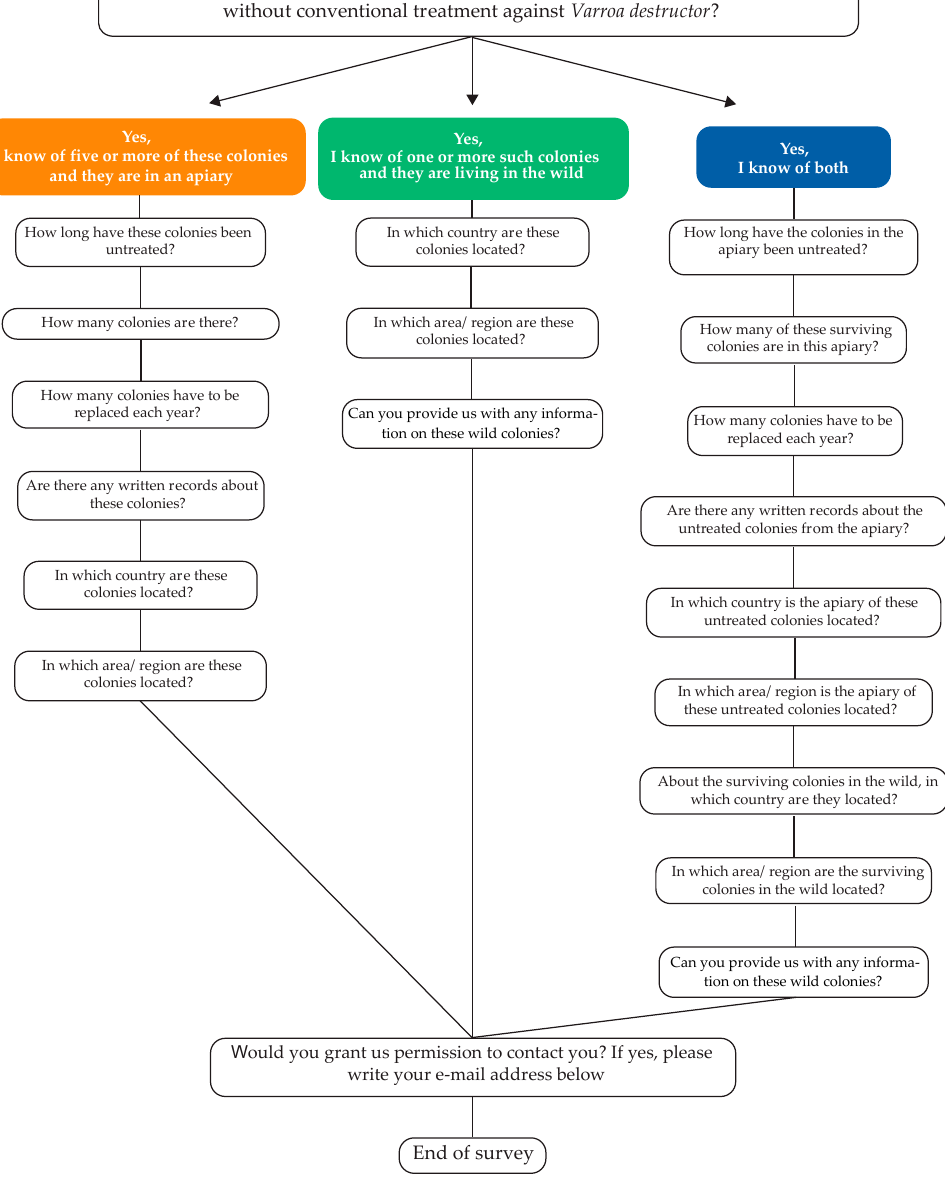
Figure 1. Flow diagram of the online survey on honey bee, Apis mellifera , colonies surviving infestations with Varroa destructor without acaricidal treatments. The first question directed respondents to one of three sections, depending on whether they intended to report cases of managed A. mellifera colonies surviving without conventional treatment against V. destructor (left), free-living surviving A. mellifera colonies (middle), or both (right).